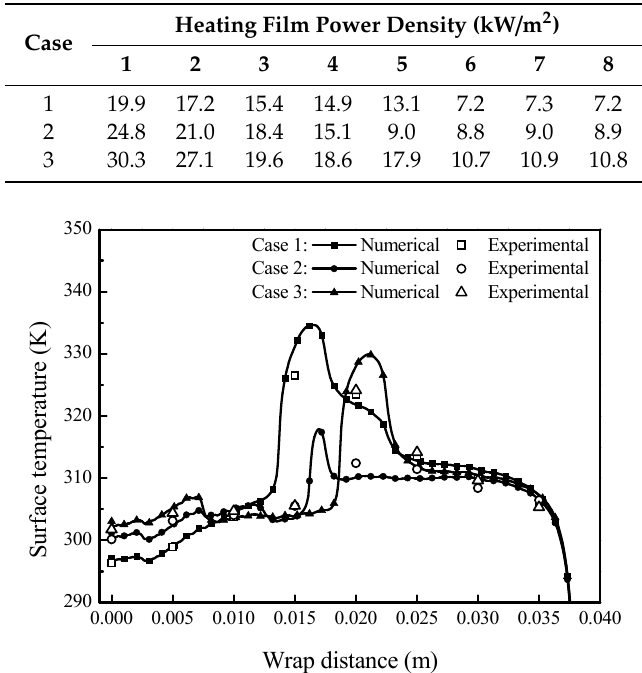
Figure 11. Numerical and experimental results of the surface temperature.